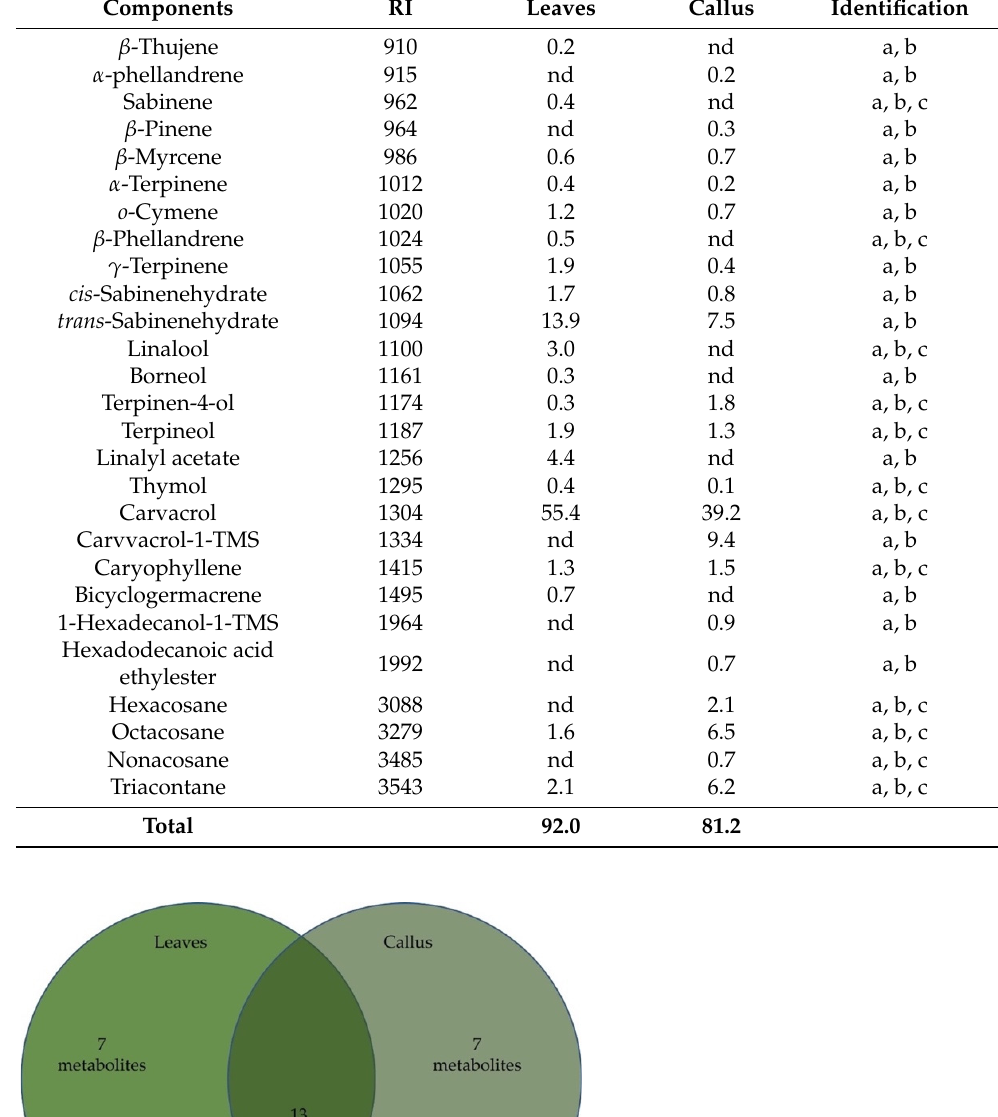
Table 2. Volatile extract analyses. Compounds are listed in order of elution from an HP-5MS column (RI = Kovats Indices calculated against C8 to C24 n-alkanes on the HP-5MS column). a = RI comparison, b = MS comparison, c = authentic sample comparison. nd: not detected.